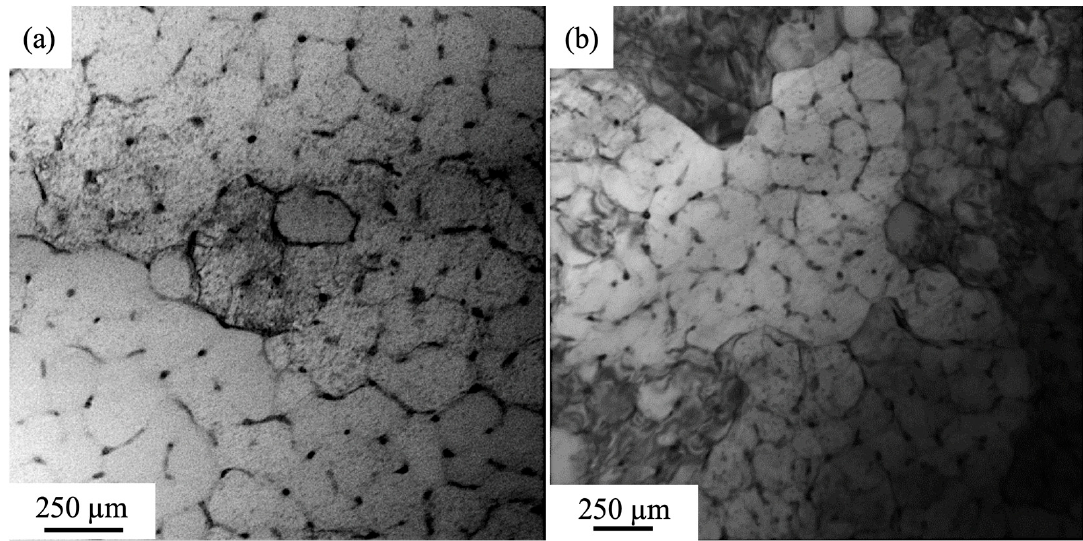
Figure 8. Images of HEA structure forming after irradiating the alloy by a pulsed electron beam; ( a ) an image obtained by a STEM-based analysis of foils; ( b ) a TEM-based analysis of foils.